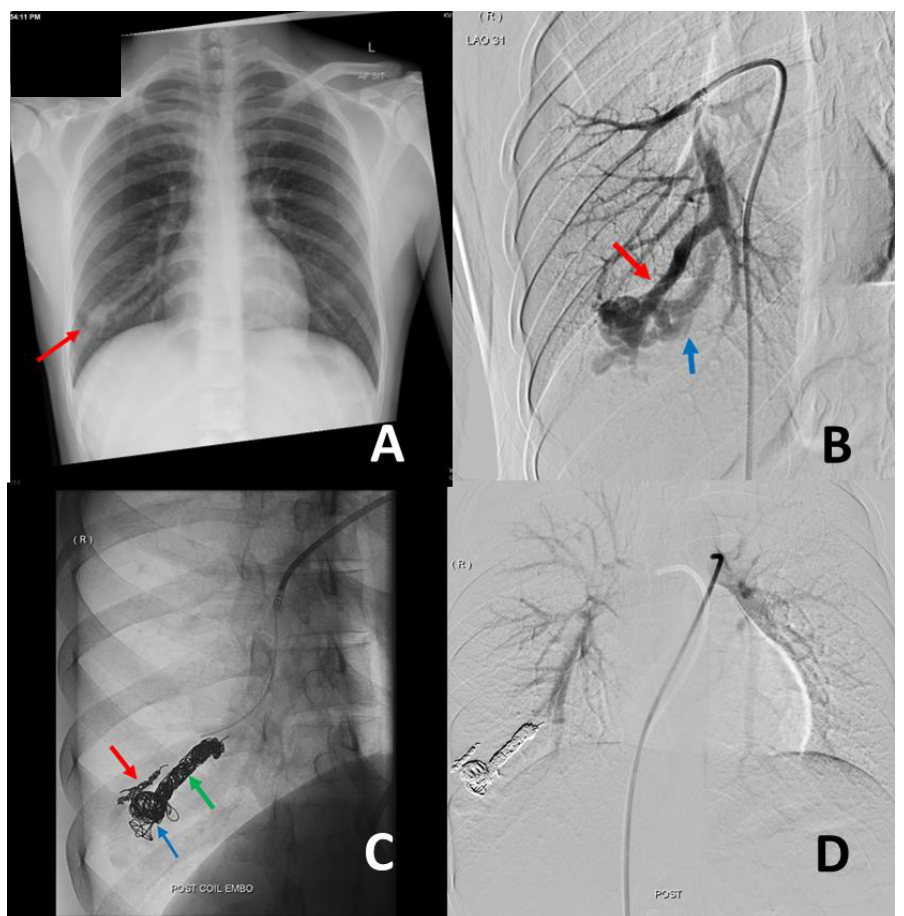
Figure 3. A 28-year-old male manual laborer presented with increasing shortness of breath and saturations of 90% on room air. Antero-posterior chest radiograph ( A ) demonstrated an ill-defined nodule (red arrow) in the right lower zone. Digital subtraction angiogram ( B ) confirmed the presence of a pulmonary arteriovenous malformation (PAVM) in the right lower lobe with a dominant feeding artery (red arrow) and a single draining vein (blue arrow). This was embolized ( C ) with a combination of Ruby ™ coils (three 10 mm × 35 cm coils, one 8 mm × 60 cm coil, and one 60 cm packing coil) and an Interlock ™ coil (6 mm × 20 cm) in the nidus (blue arrow) and the dominant feeding artery (green arrow). An accessory feeding branch (red arrow) was embolized with a Ruby ™ coil (3 × 20 mm). Post-procedure angiogram ( D ) via the main pulmonary artery confirms complete occlusion of the PAVM.